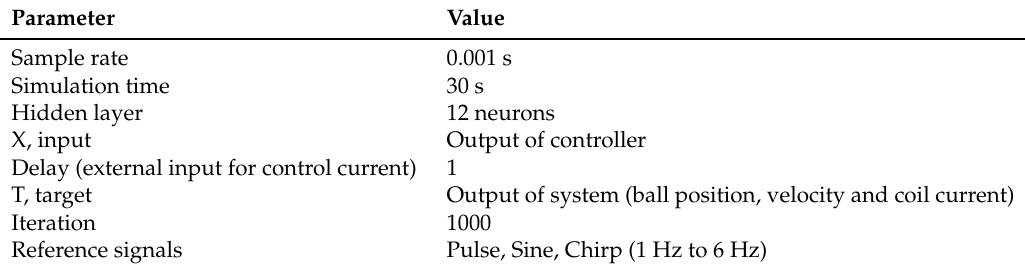
Table 2. The parameters of the neural network.